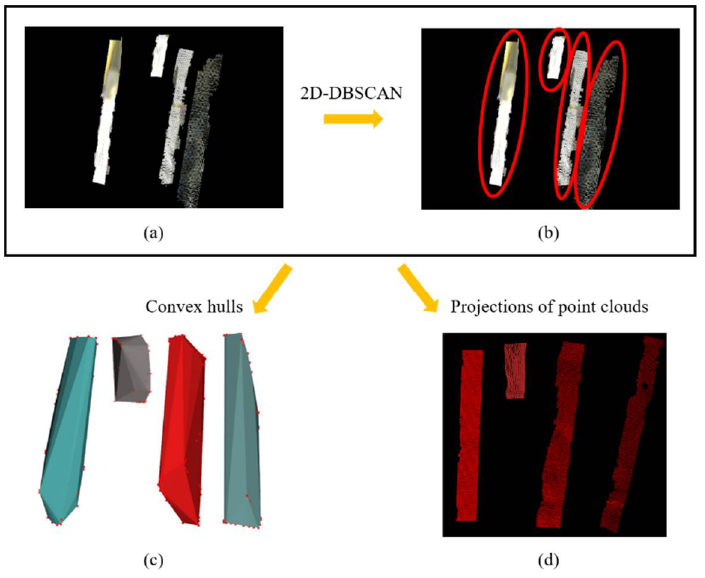
Figure 13. Convex hulls and plane projections of stem point clouds. ( a ) Stem point clouds; ( b ) point